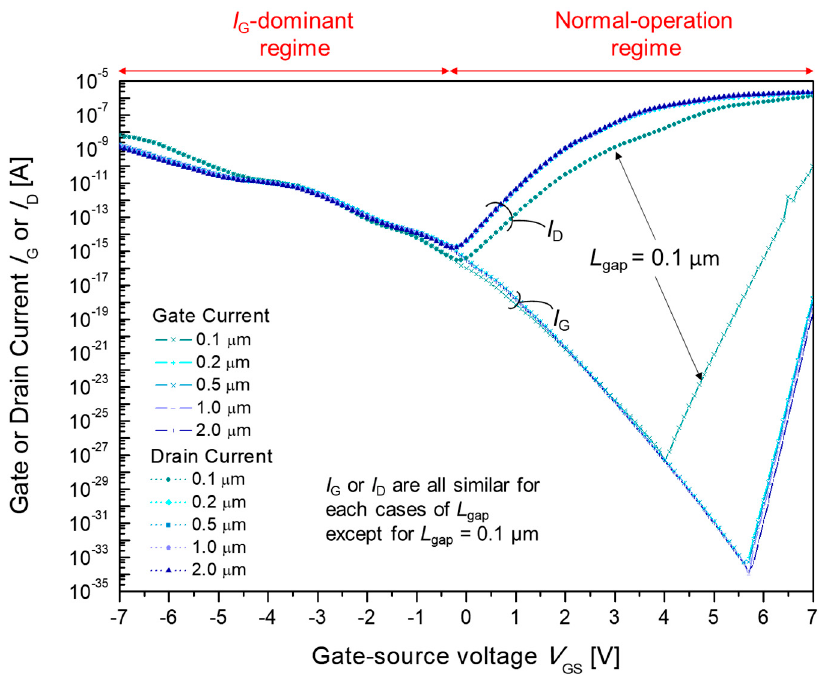
Figure 5. Simulated gate current I G and drain current I D for various source/drain-gate gaps, L gap . L gap was divided into five separate cases of 0.1, 0.2, 0.5, 1.0 and 2.0 µm.